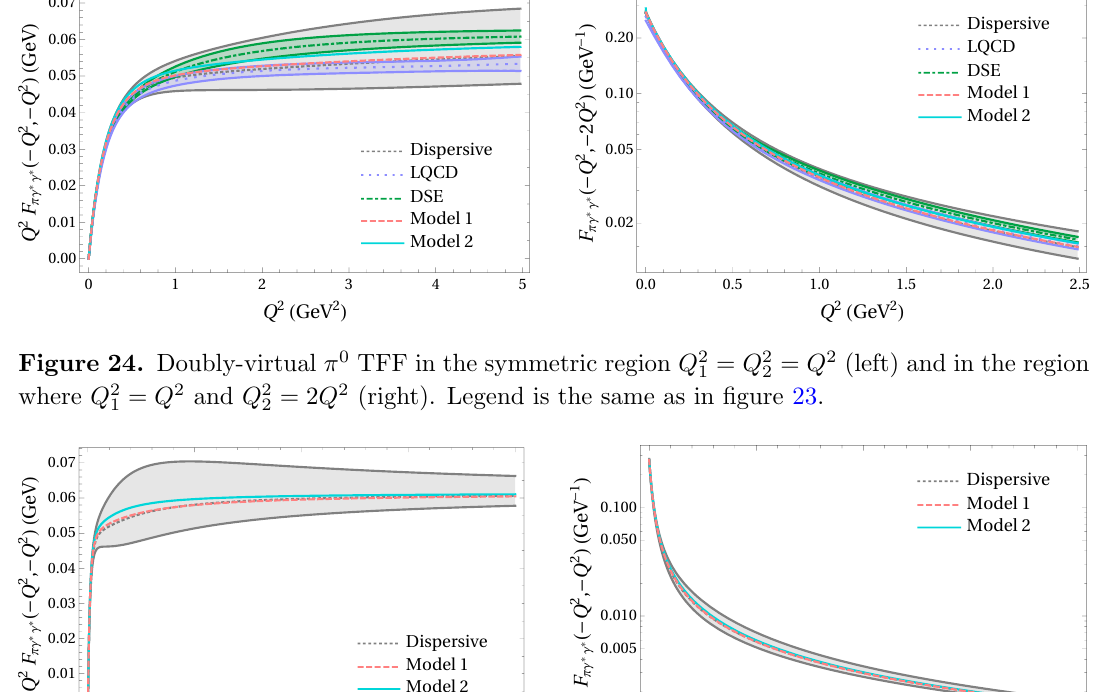
Figure 25. Doubly-virtual (cid:25) 0 TFF in the symmetric region Q 2 Legend is the same as in (cid:12)gure